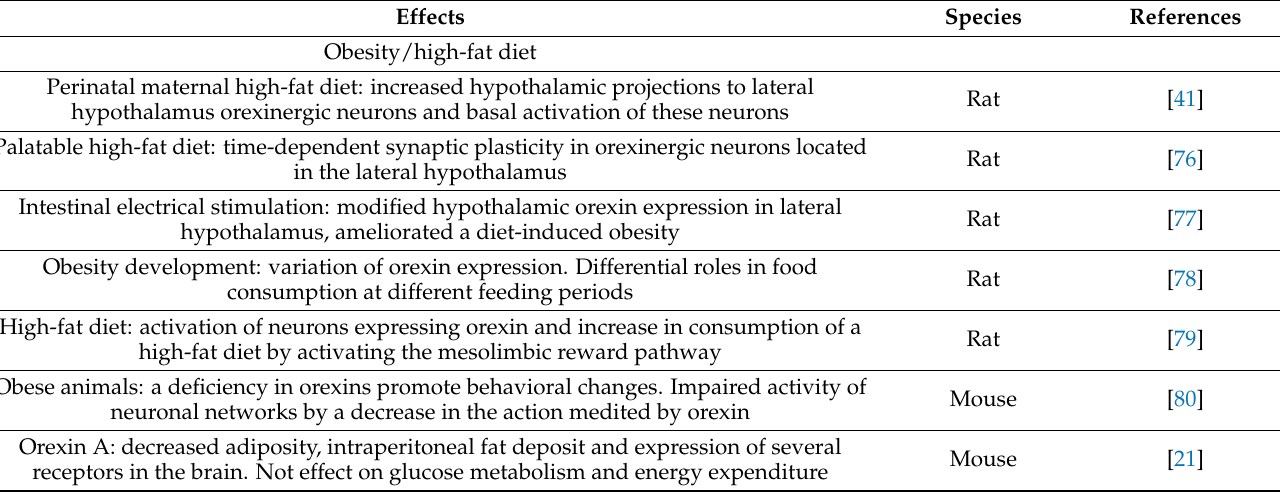
Table 3. Orexins and food intake: experimental animal